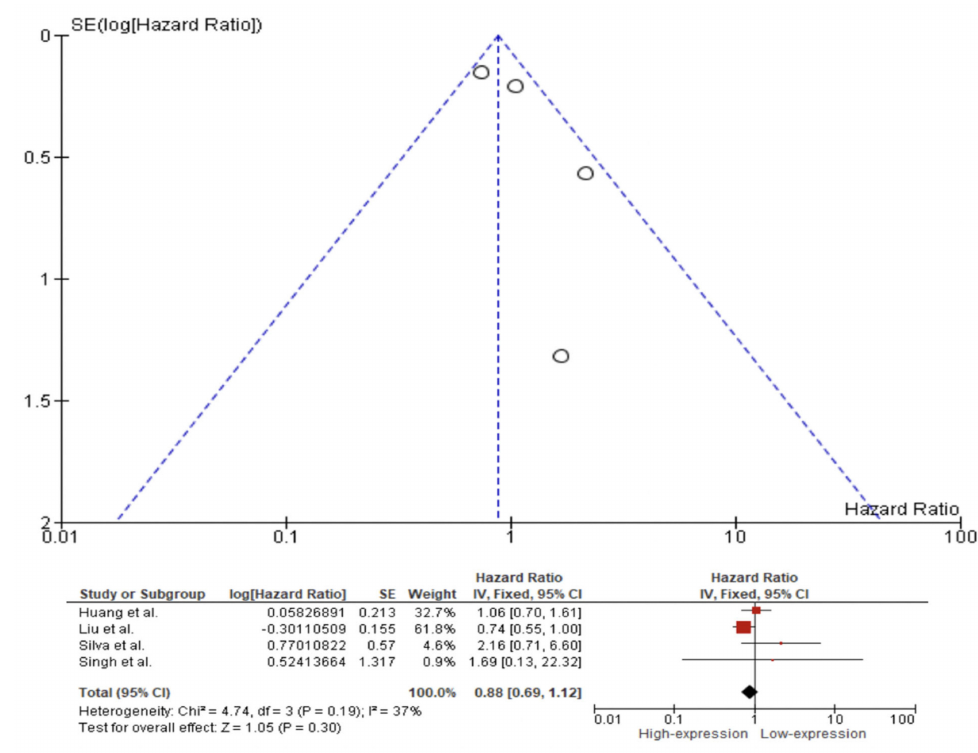
Figure 6. Forest plot and funnel plot for the association of higher Caspase 3 expression with disease-specific survival. Squares represent study-specific hazard ratios; horizontal lines represent 95% confidence intervals (CIs); diamonds represent the overall hazard ratio estimate with its 95% CI